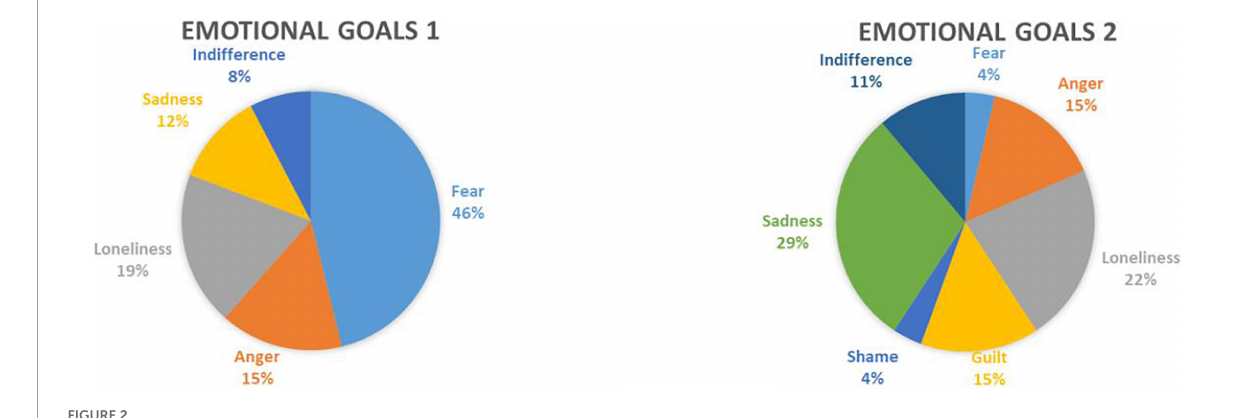
FIGURE2 Emotions participants wanted to work on in the Feel-Good intervention.